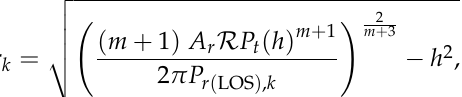
Figure 2. Overview of the visible light channel.